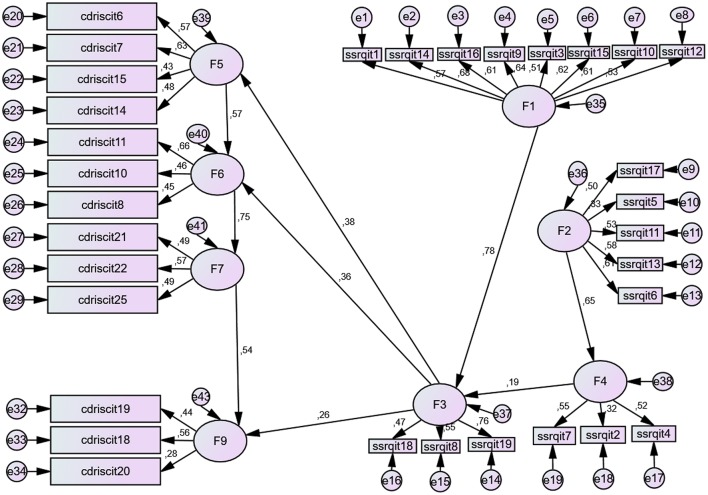
Structural model of relations between resilience and self-regulation. Self-regulation: F1, Goals; F2, Perseverance; F3, Learning from mistakes; F4, Decision making. Resilience: F5, Coping and confidence; F6, Tenacity and adaptation; F7, Perception of control and achievement; F8, Perception of support; F9, Tolerance of Negative Situations. For the items, see Annexes I and II in Supplementary Meterial.